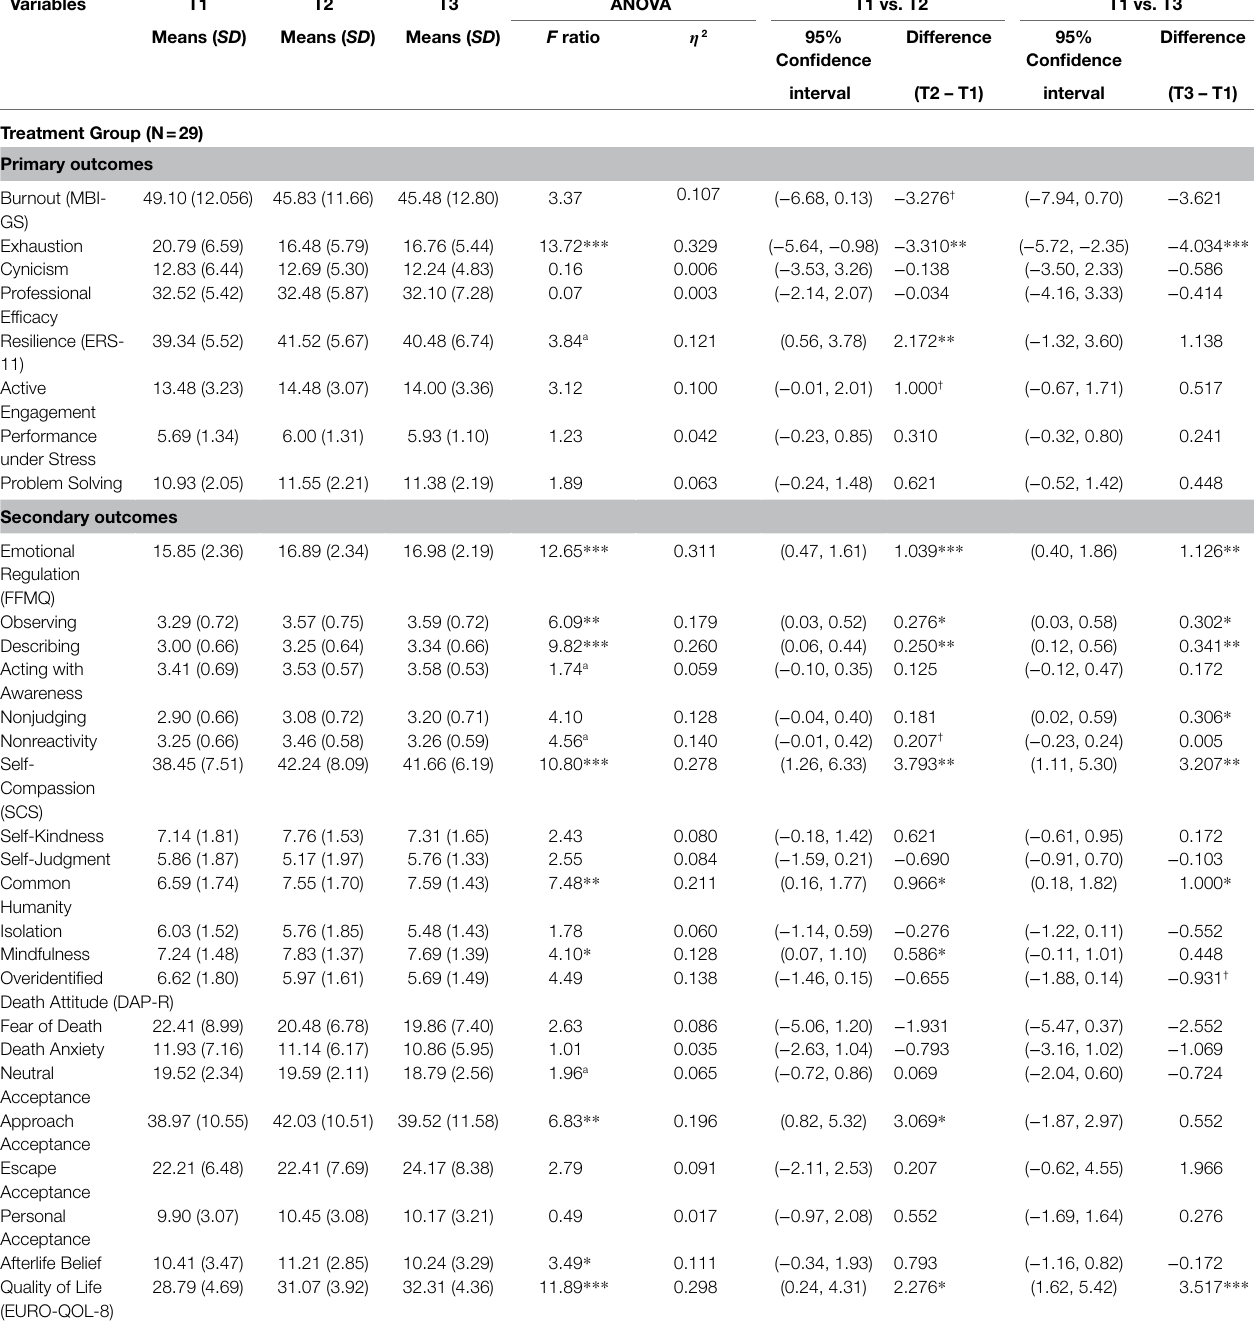
TABLE 4 | Within treatment group analysis using one-way ANOVAs.